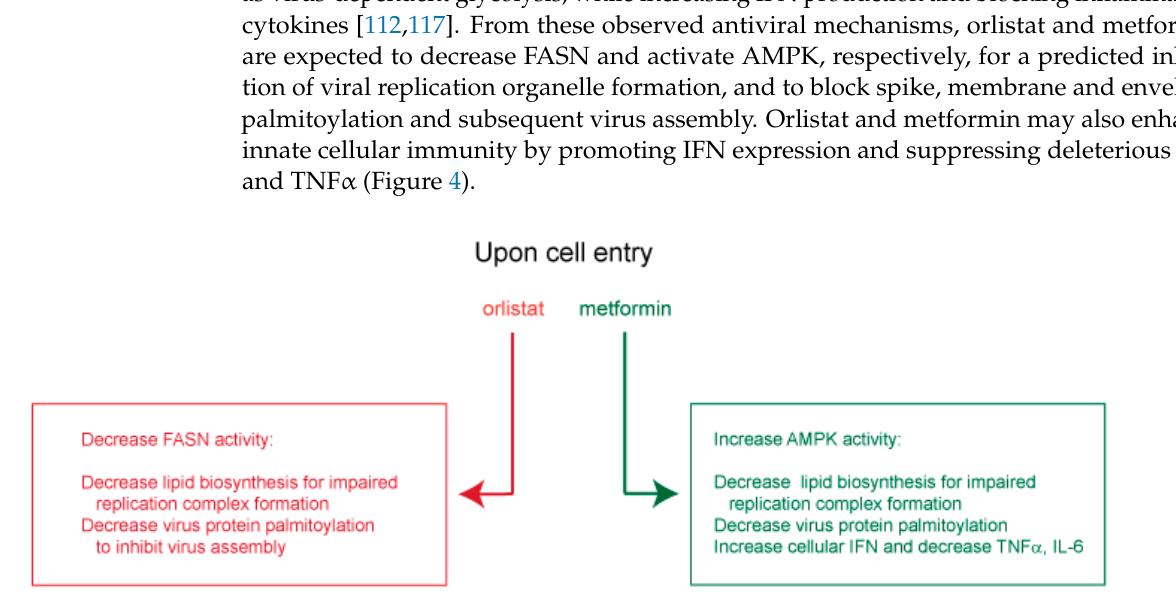
Figure 4. Predicted mechanisms of action used by orlistat and metformin to inhibit SARS-CoV-2 replication. 7.2. Potential Clinical Utility of Orlistat and Metformin in COVID-19 Treatment